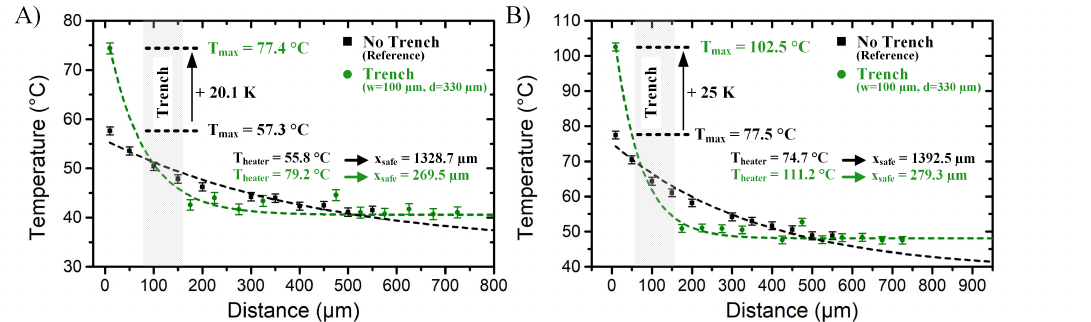
Figure 7. Comparison of the temperature profile along the reference sample and a demonstrator with trenches. The demonstrator shown has a 100 µ m wide and 330 µ m deep trench. Although the trench is extremely powerful in thermally decoupling the two chip regions (relatively flat temperature profile after the trench), due to the reduced area for heat dissipation, the heat source reaches a higher temperature at constant applied power. ( A ) Measurements performed using 3.71 W heating power. ( B ) Measurements performed using 5.74 W heating power.